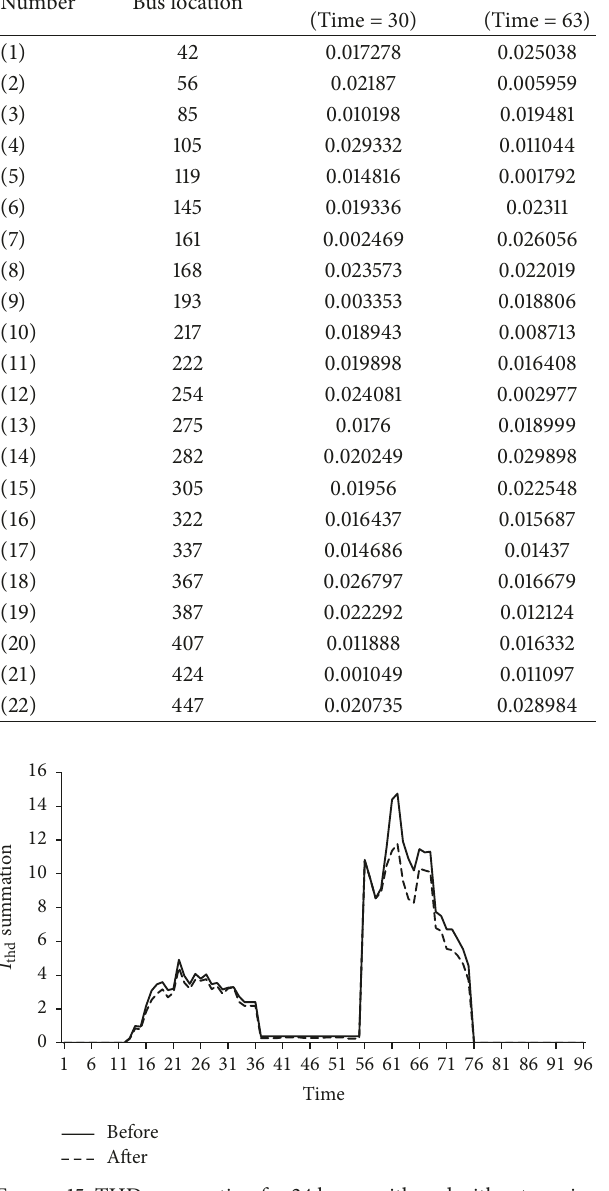
Figure 16: Apparent power losses for 24 hours with and without passive